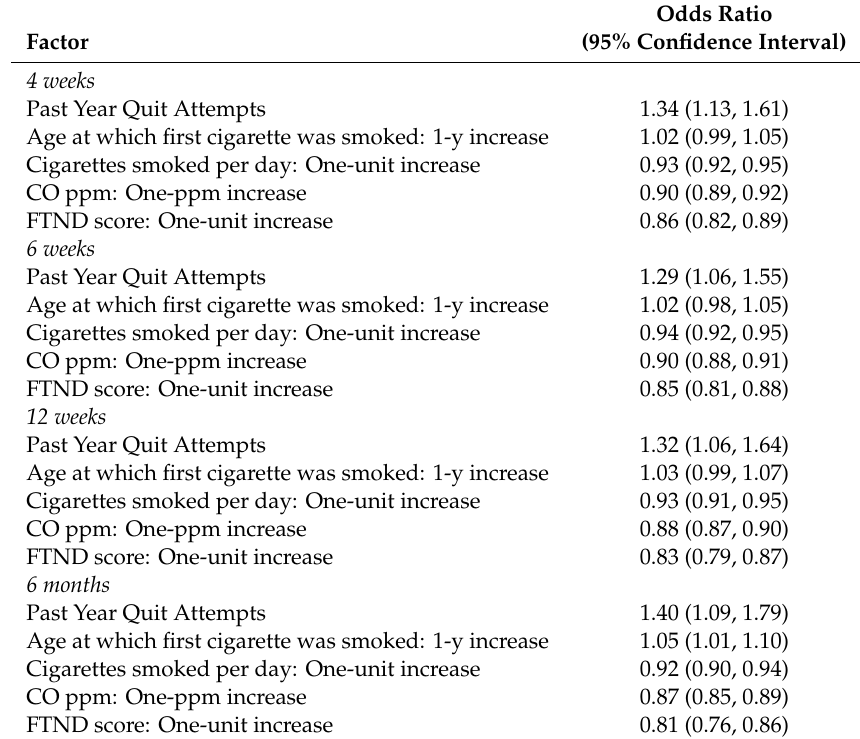
Table 4. Adjusted odds ratios and 95% Confidence Intervals from the logistic regression models for the factors a ff ecting smoking abstinence.